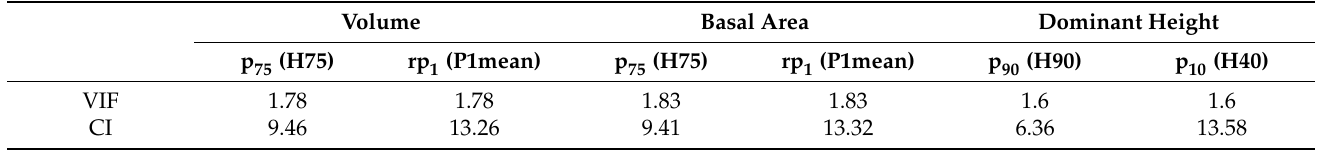
Table 5. The collinearity index value for all variables selected in the LS model for volume, basal area, and dominant